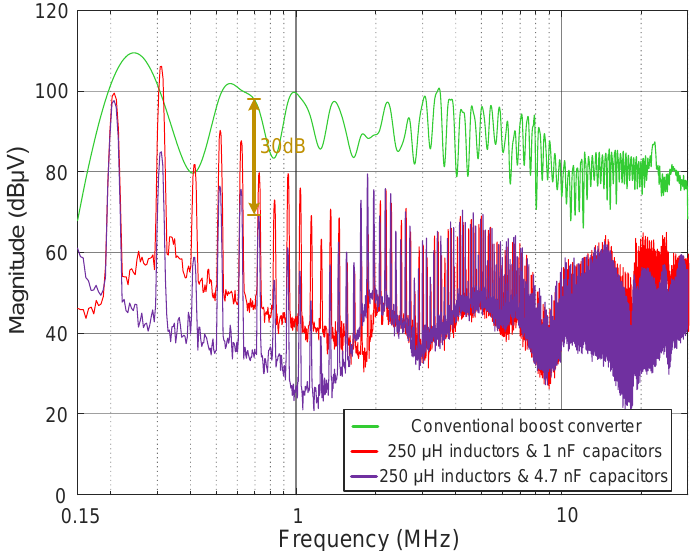
Figure 15. CM noise comparison after replacing the 1 nF Y-capacitors with 4.7 nF Y-capacitors.